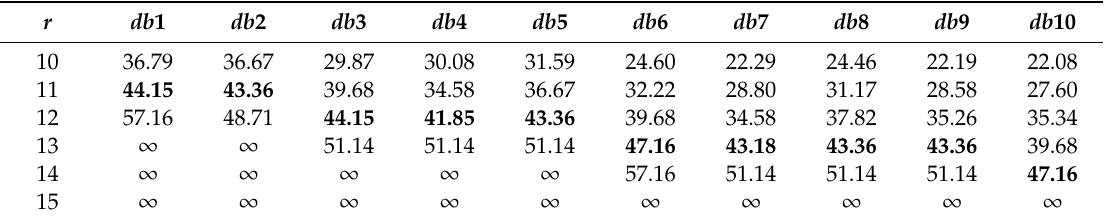
Table 1. Calculation results ( PSNR , dB) of 3D medical images (with 8 BPC) DWT by using bit-width r of Daubechies wavelets filters coe ffi cients.